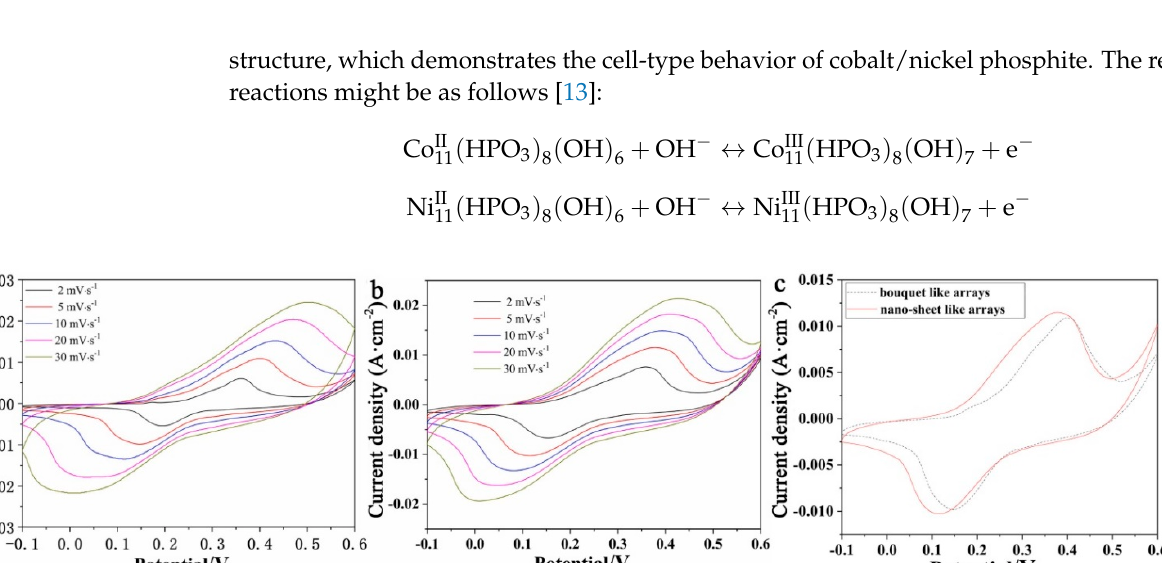
Figure 4. CV curves of ( a ) MHP bouquet arrays/ACF electrode; ( b ) MHP nano-sheet arrays/ACF electrode; ( c ) both electrodes at scan rate of 5 mV/s.